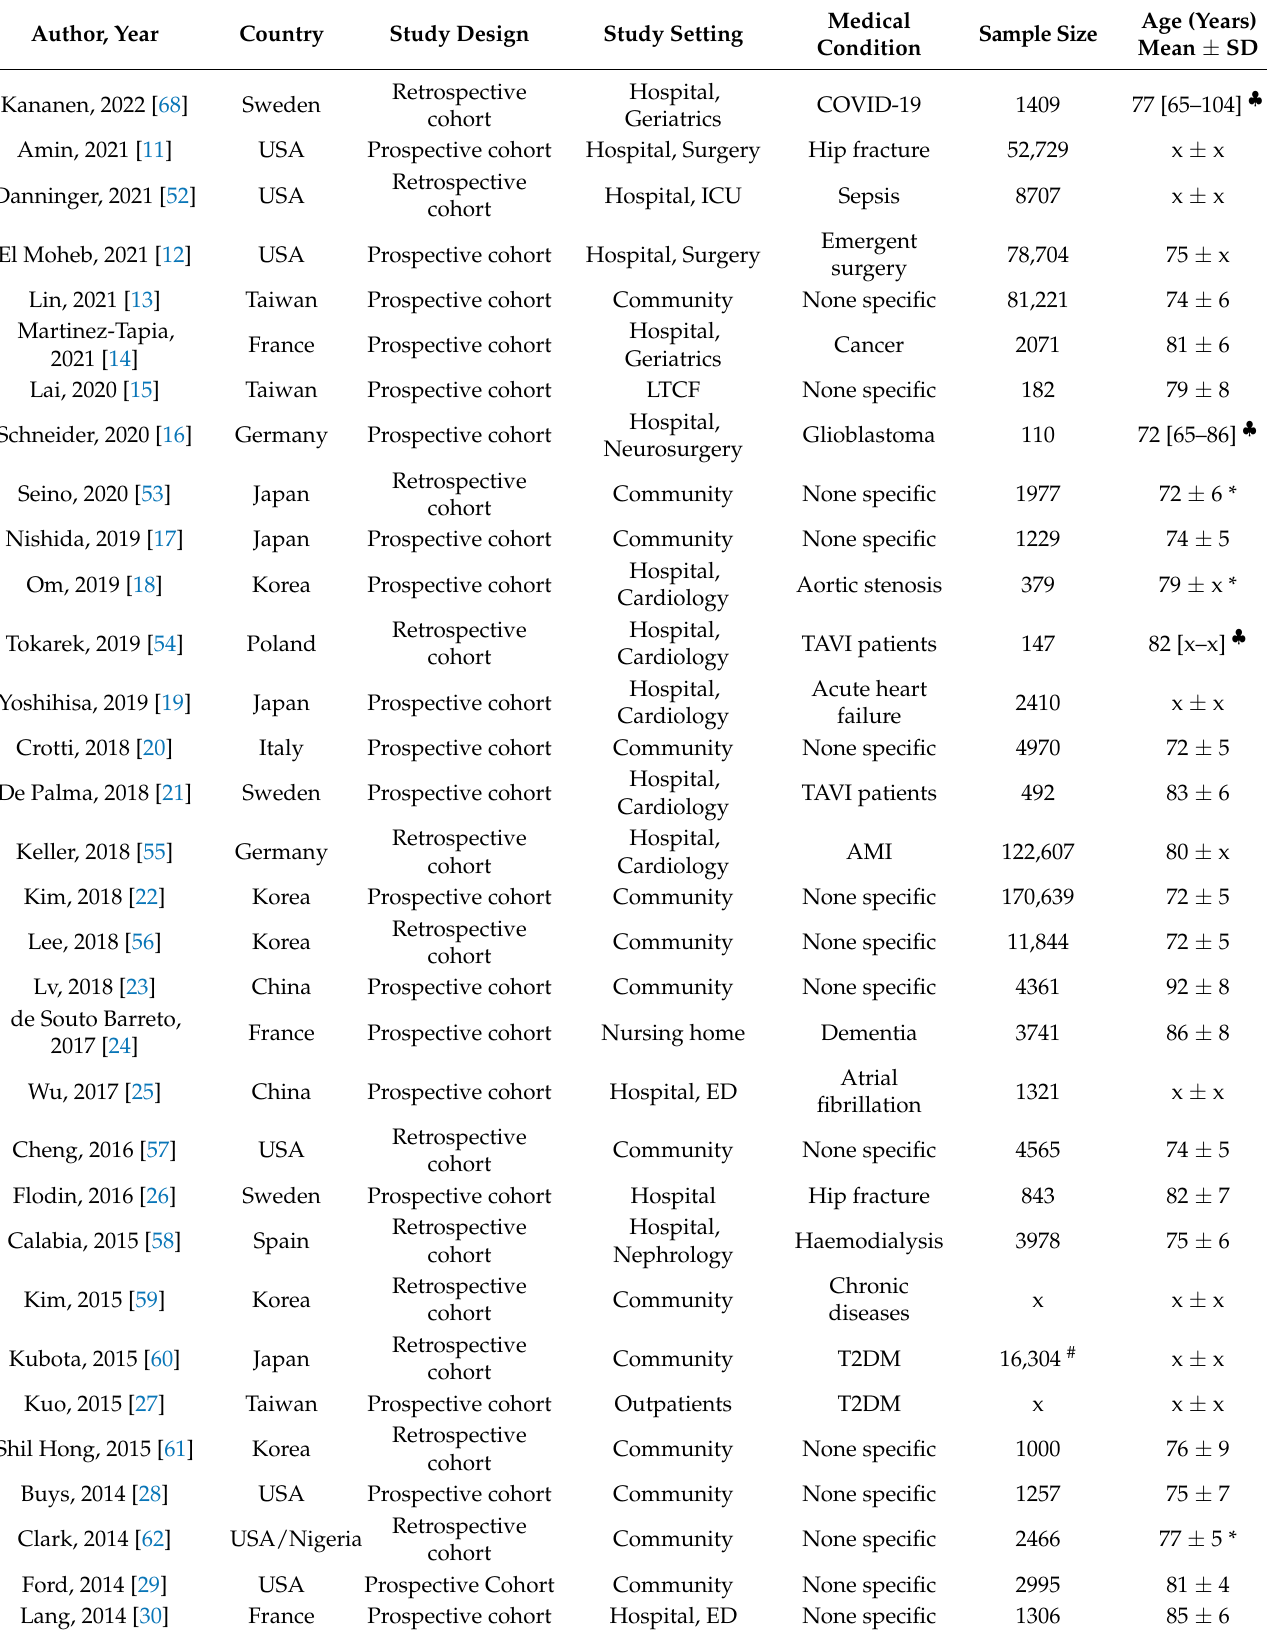
Table 1. Description of the studies included in the present systematic